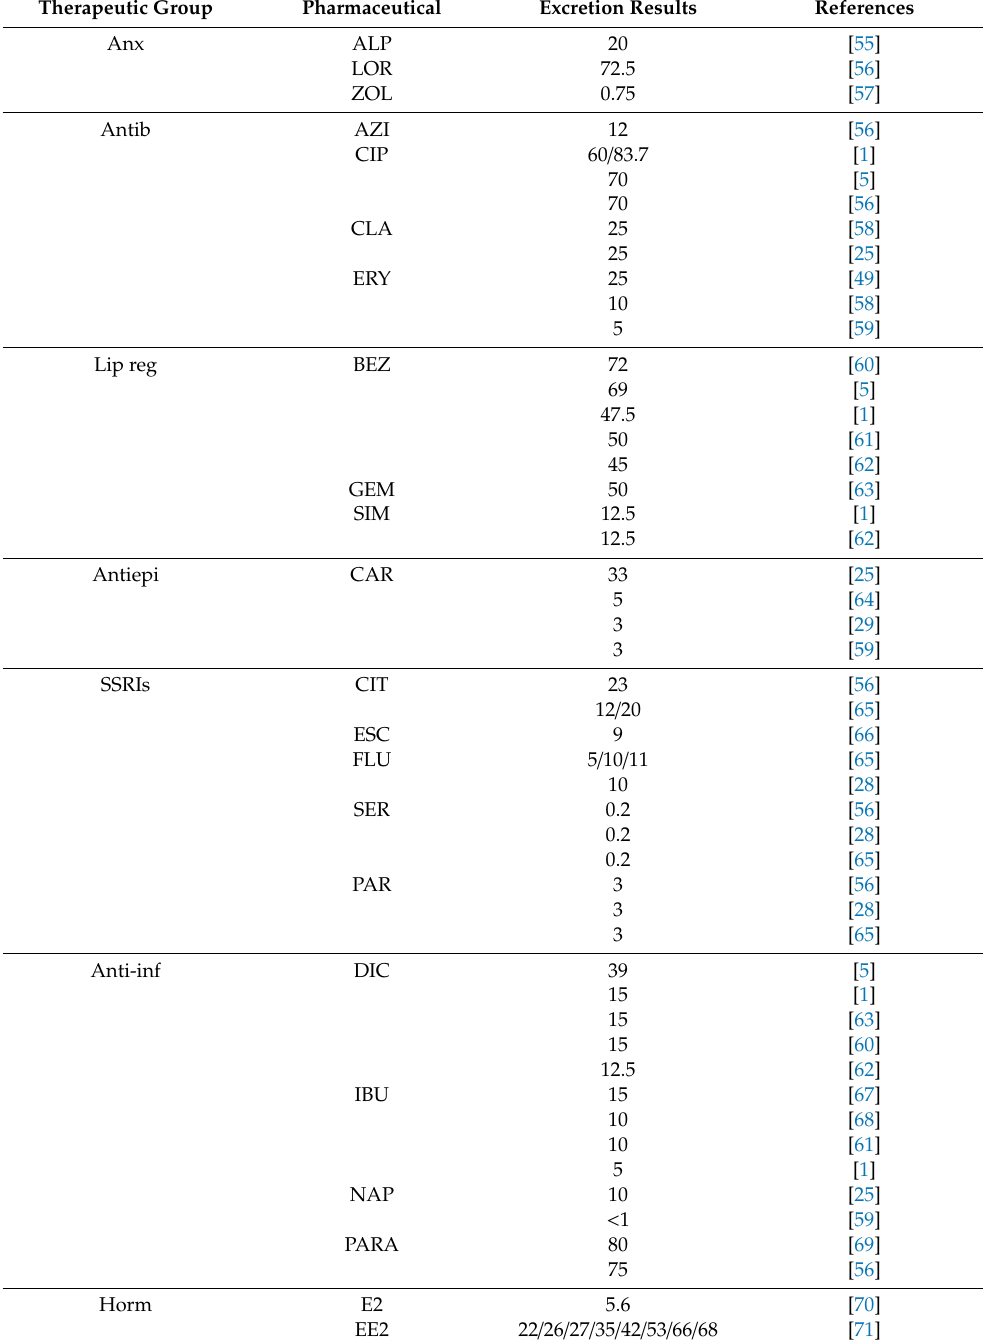
Table 3. Excretion rates of the selected